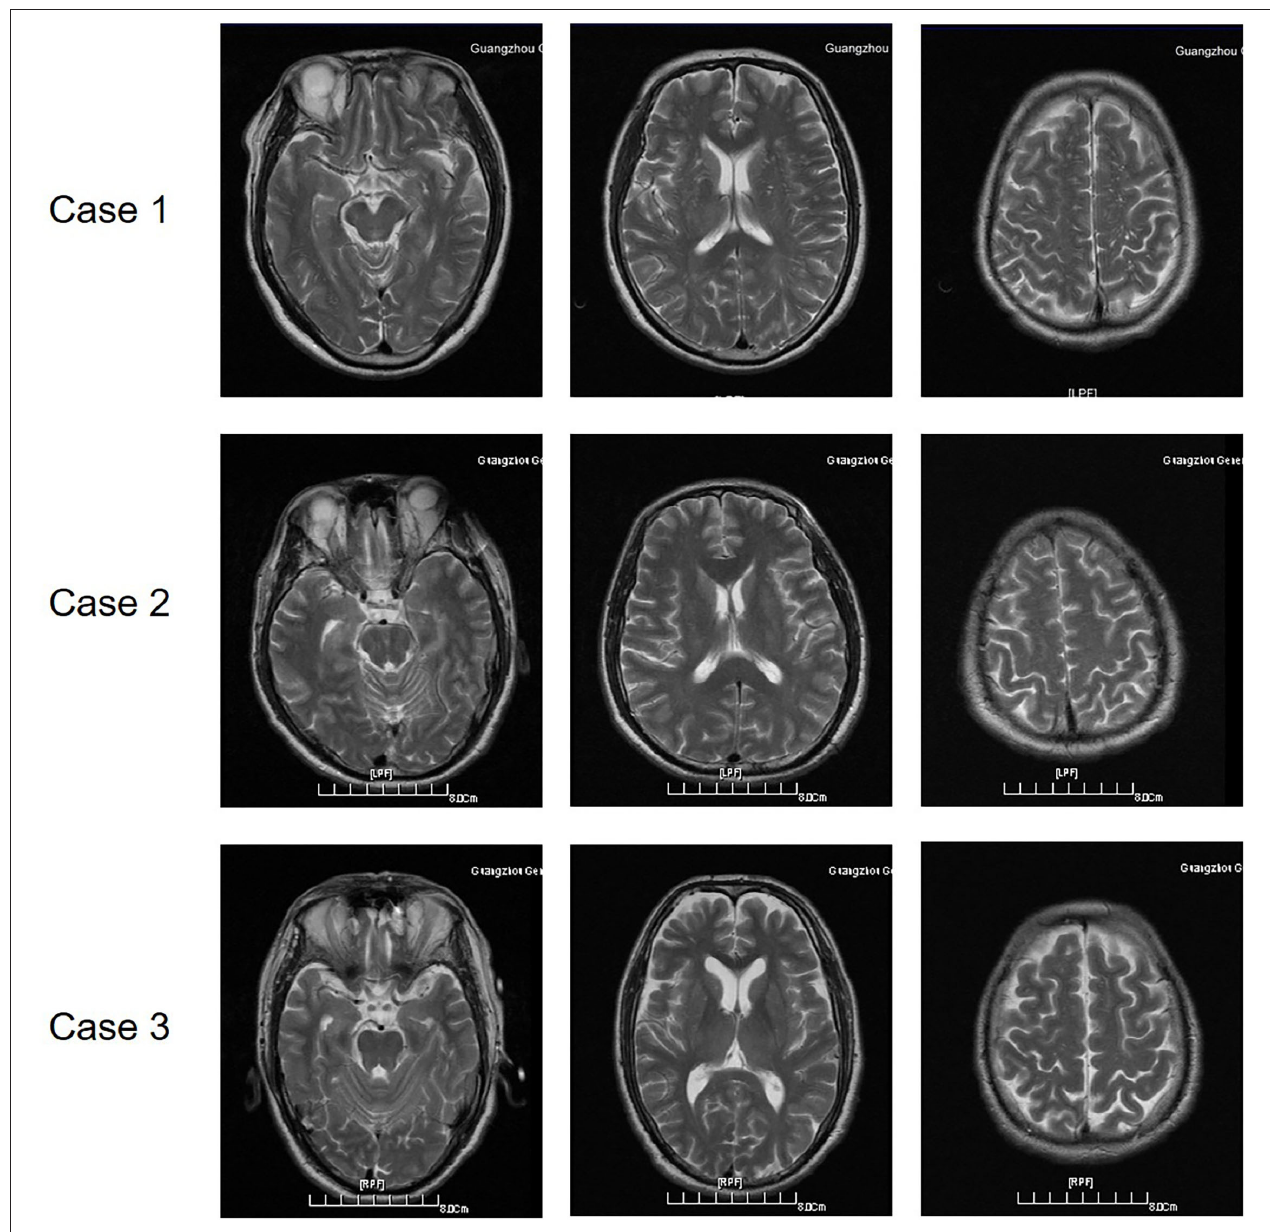
FIGURE 1 | The brain magnetic resonance imaging (MRI) of the three patients with GBS induced by HS.